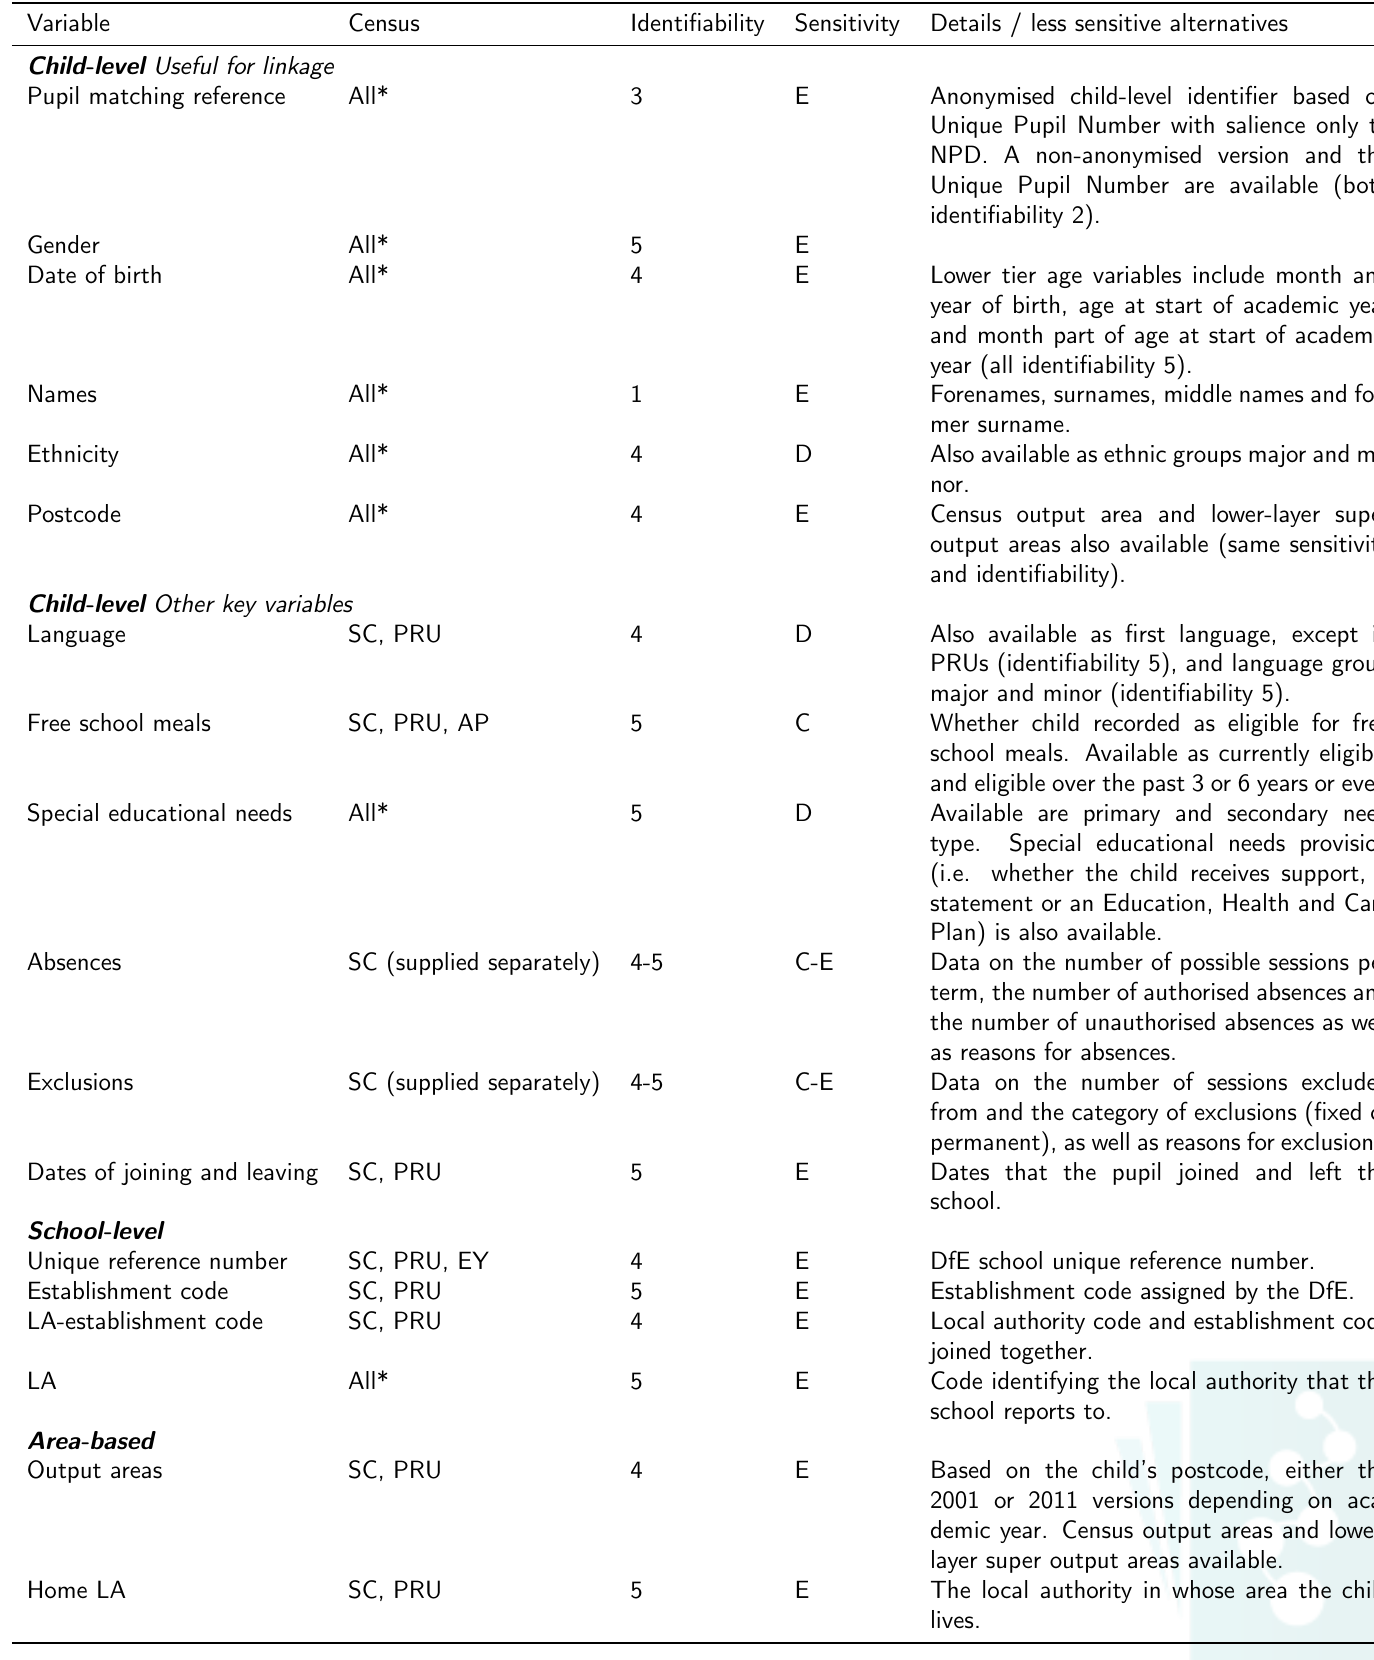
Table 2: Key variables in National Pupil Database